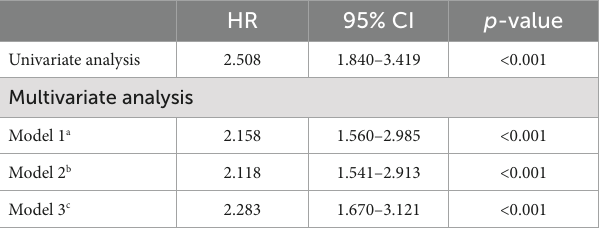
TABLE 3 Risk of death associated with apathy in unadjusted and adjusted Cox model. HR p